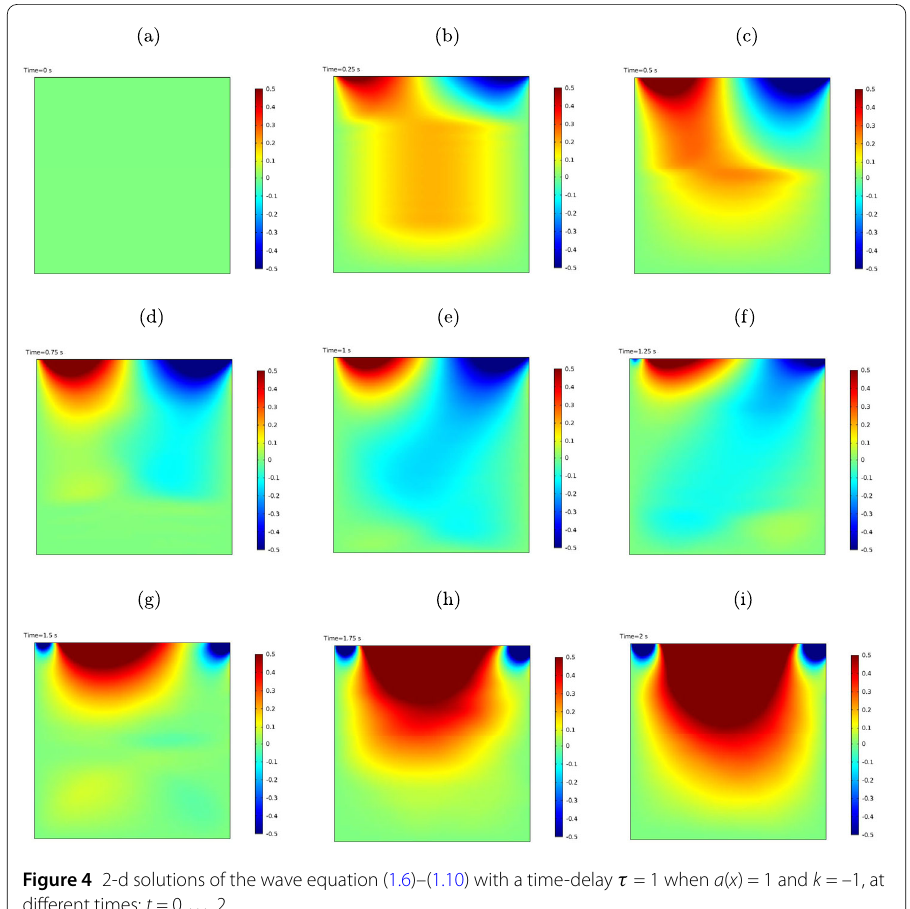
Figure 5 The energy E 0 ( t ) of the system (1.6)–(1.10) with a delay τ = 1 when a ( x ) = 1, and k =